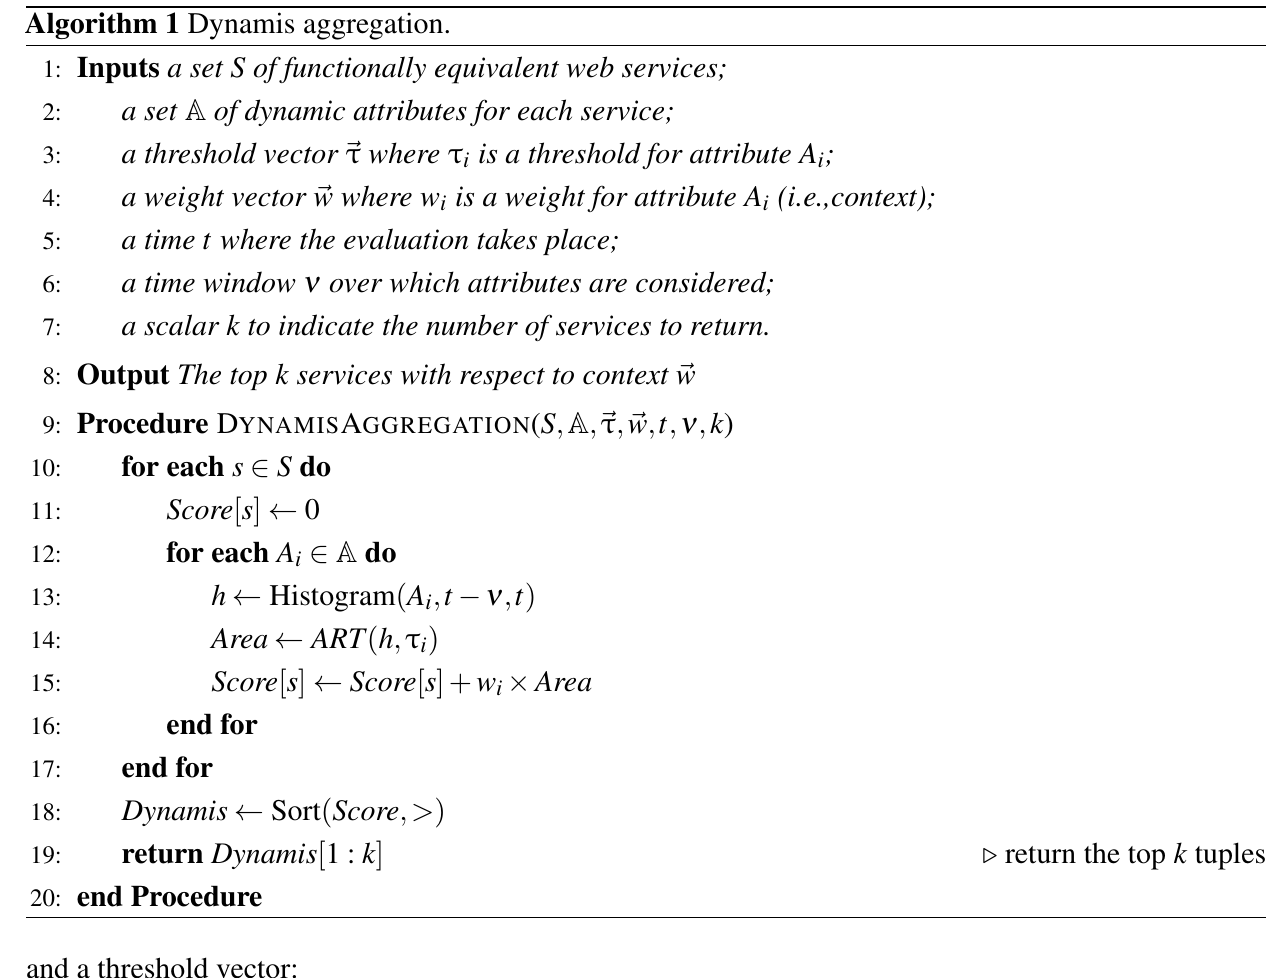
Algorithm 1 Dynamis